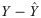
a) Violin graphics to represent the difference of actual data from the theoretical Fourier model (Y-Y^) for each isolation. This graph allows the easy visualisation of the distribution of the data and its probability density. b) Direct representation of (Y-Y^). Colour represents the density of points in a given area. Lighter colour (yellow) determines higher data density. It should be noted that both graphs are presented on a logarithmic scale. The differences between predictions are shown in Celsius degrees.